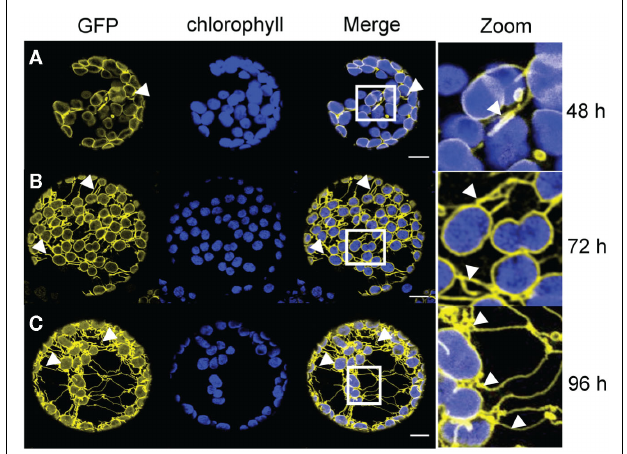
FIGURE 5 |Time course analysis of expression patterns for AtLACS9–GFP in N. benthamiana protoplasts. Time based confocal microscopic analysis on isolated protoplasts of N. benthamiana leaves after 35S-promoter driven in planta expression of AtLACS9–GFP. GFP fluorescence (GFP) in yellow, chlorophyll autofluorescence (chlorophyll) in blue, an overlay (merge) and a magnification (zoom) of representative protoplasts are shown.The white box indicates the merged region magnified under zoom. (A) Expression pattern 2days (48h) after Agrobacterium infiltration shows ring structures surrounding the chloroplasts with slight extensions proliferating from the ring. (B) Expression pattern 3days (72h) after Agrobacterium infiltration displays more pronounced extensions in addition to ring like structures surrounding the chloroplasts. (C) Expression pattern 4days (96h) after Agrobacterium infiltration shows a network of GFP labeled structures surrounding the chloroplasts, spanning though the entire protoplasts and connecting chloroplasts. Size bars: 10 μ